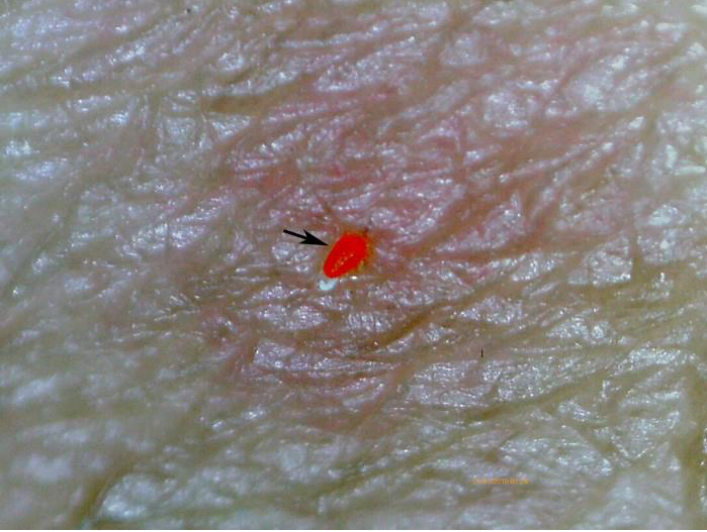
Figure 13. Trombicula alfreddugesi identified by the digital handheld microscope (arrow); magnification 10-fold.